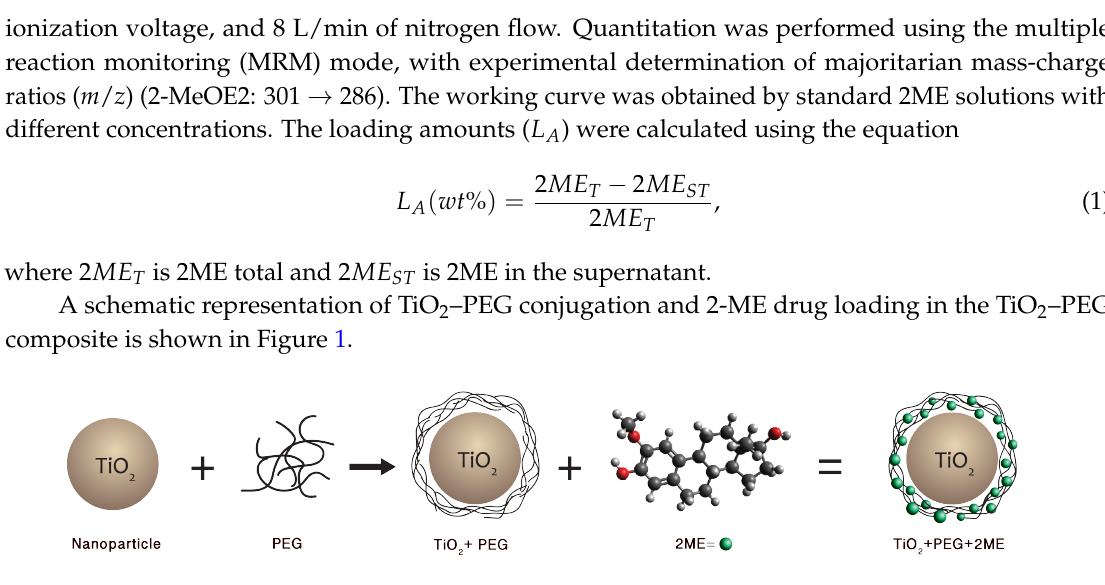
Figure 1. Schematic representation of the functionalization of PEG–TiO 2 and TiO 2 –PEG–2ME (2ME image is supported by [25]). (2ME: 2-Methoxyestradiol; PEG: polyethylene